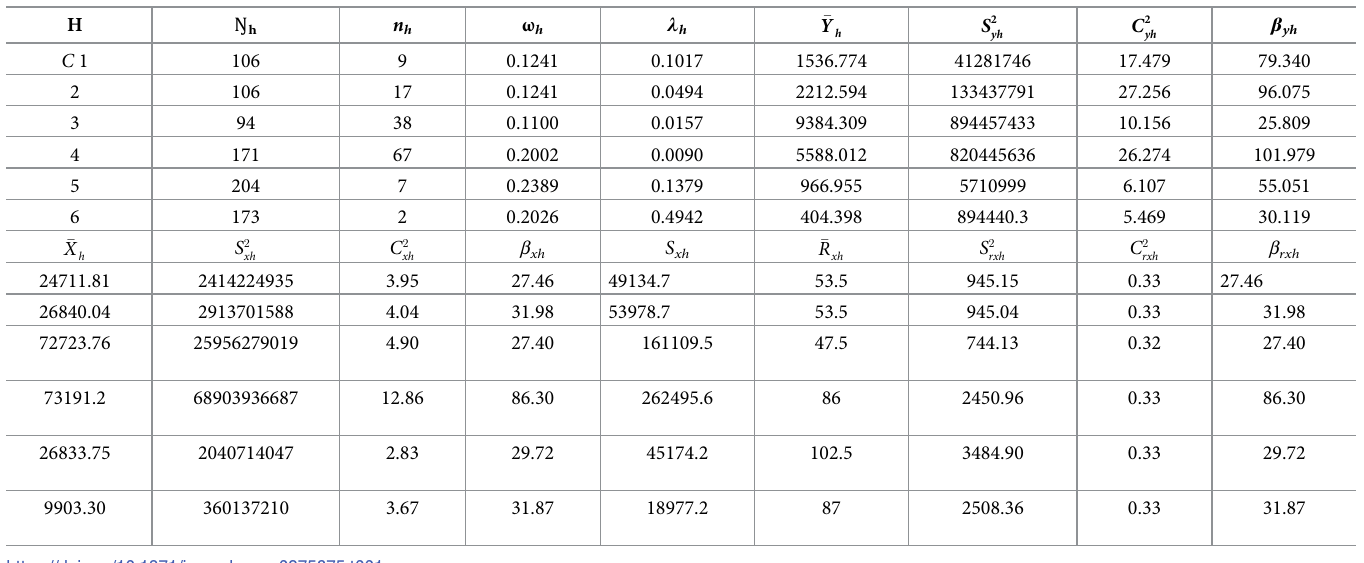
Table 1. Summary statistics of Population-I.